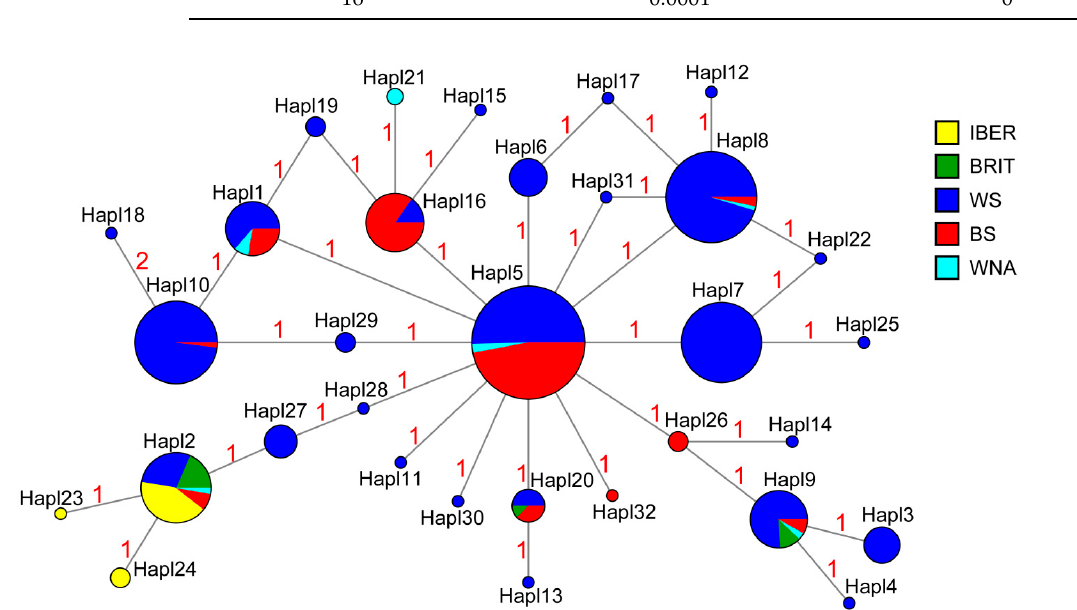
Figure 3. Median-joining haplotype network of the COI sequences of Margaritifera margaritifera dataset ( n = 457), delineating five groups of populations. The red numbers near branches indicate the numbers of nucleotide substitutions between haplotypes. Size of circles corresponds to the number of available sequences for each haplotype (smallest circle = 1 sequence). The list of sequences is presented in Table S1.